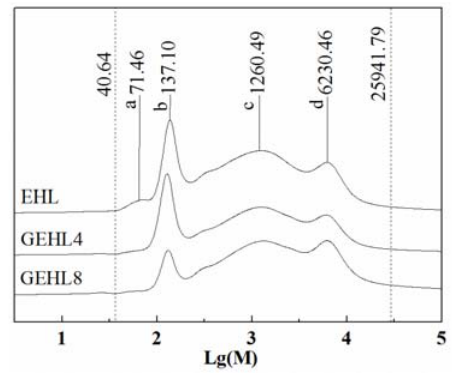
Figure 6. The GPC curves of EHL and GEHL.